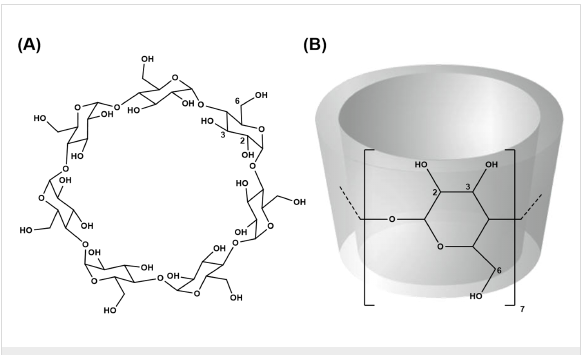
Figure 2: (A) Chemical structure of β -CD and (B) its truncated cone